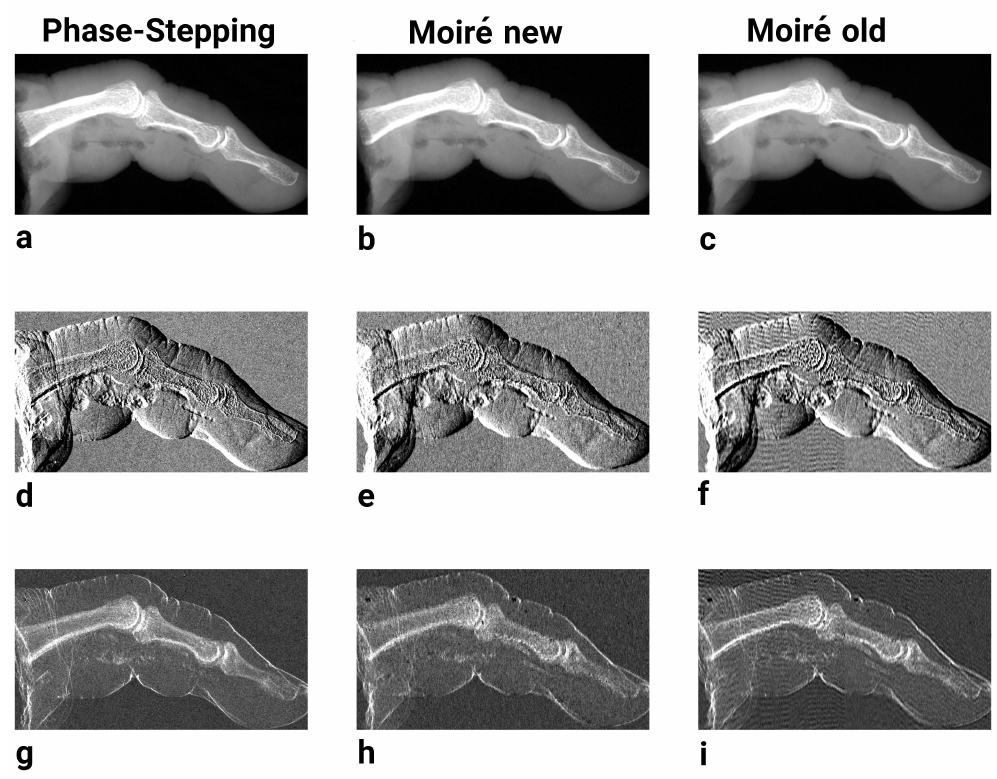
Figure 10. Images of a human finger, ex-vivo. The images in the left column ( a , d , g ) are reconstructed using the phase-stepping approach. In the middle ( b , e , h ), the images of the moiré imaging approach using the improved algorithm are depicted. In the right column ( c , f , i ), the images of the moiré approach reconstructed with the conventional method are shown. ( a , b , c ) attenuation images, ( d , e , f ) differential phase-contrast images and ( g , h , i ) dark-field images. The corresponding images are obtained with the same dose of 450mAs at 40kVp and are plotted with the same color